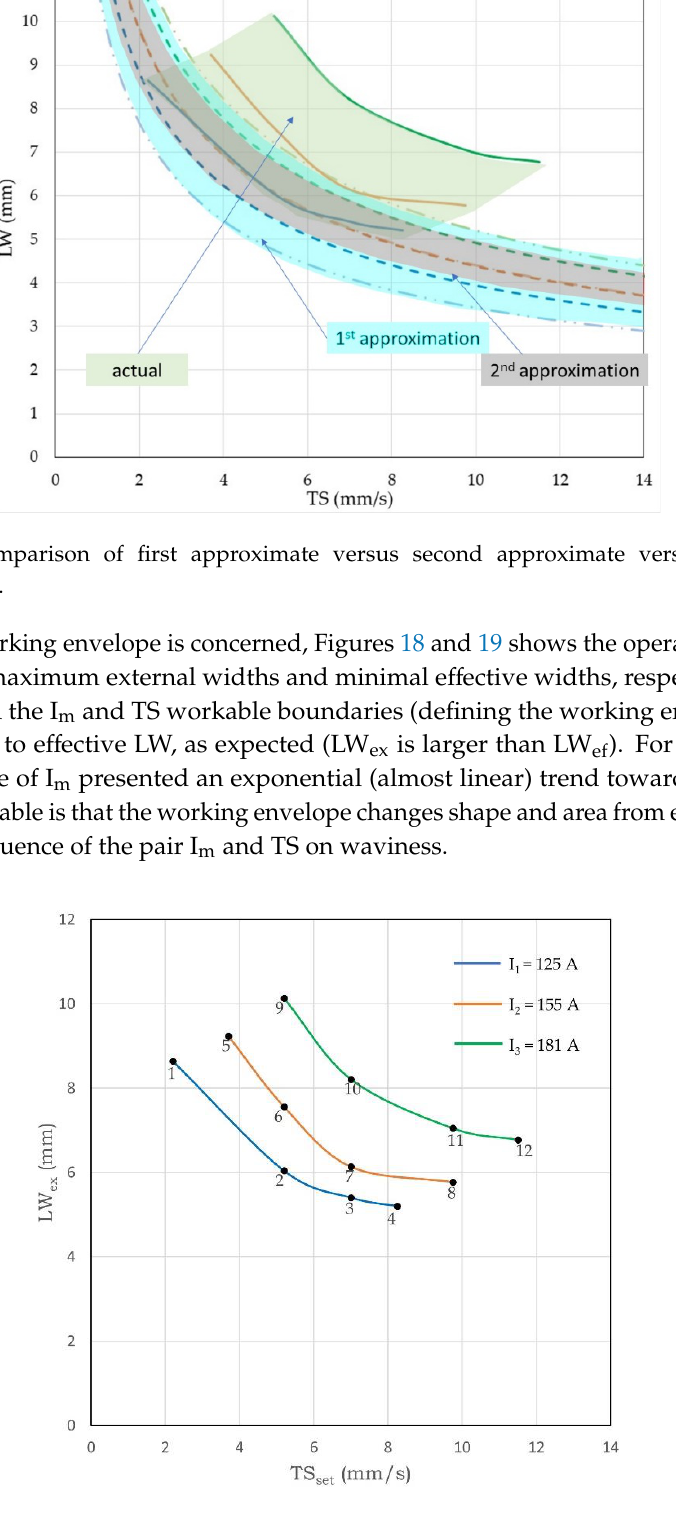
16 of 21 Figure 16. Representation of: ( a ) maximum external LW (LW ex ); ( b ) minimum effective LW (LW ef ). Table 8. Experimental responses: external layer width (LW ex ) and effective layer width (LW ef ). Exp.